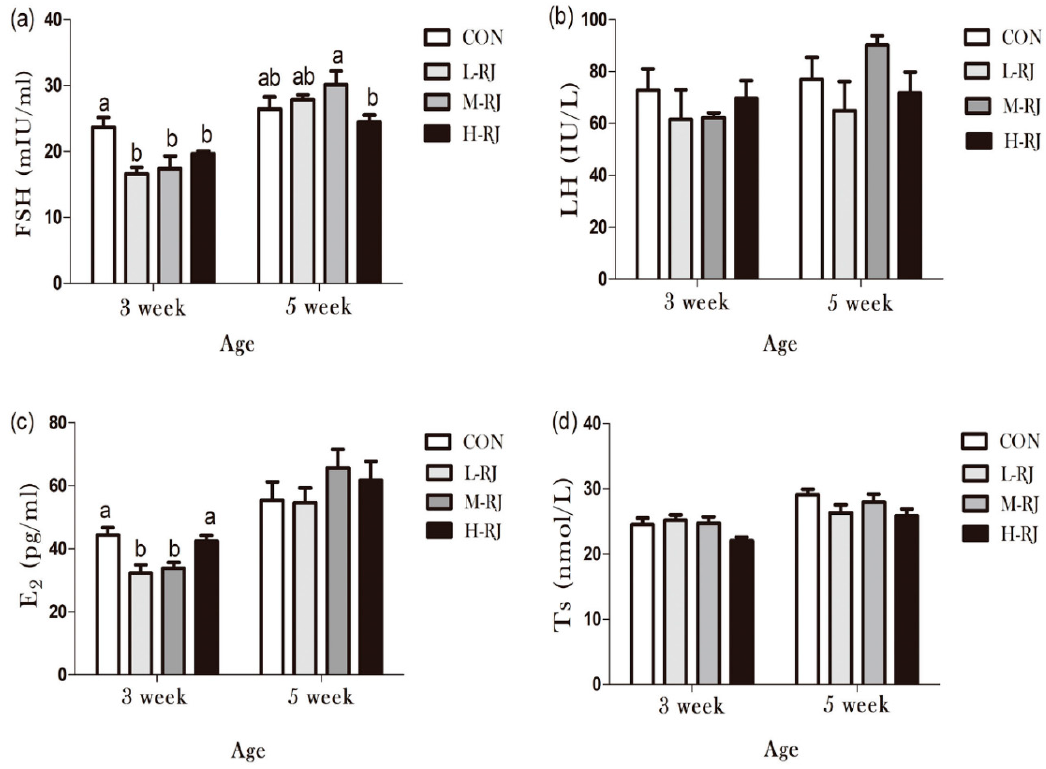
Figure 9. Reproductive hormones secretion level of pubescent male mice exposed to oral freeze-dried royal jelly. Data are shown as mean ± SE (n = 7) and di ff erent letters ( a , b , c ) within a column represent significant ( p < 0.05) di ff erences among groups. Some abbreviated letters indicate the following: Follicle Stimulating Hormone (FSH), Luteinizing Hormone (LH), Estradiol2 (E2) and Testosterone (T).